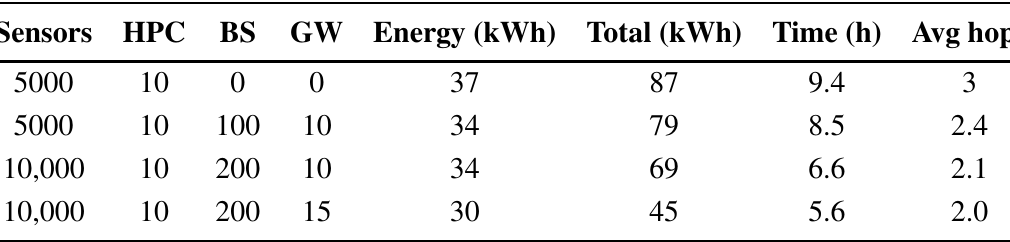
Table 3. Green Allocation algorithm